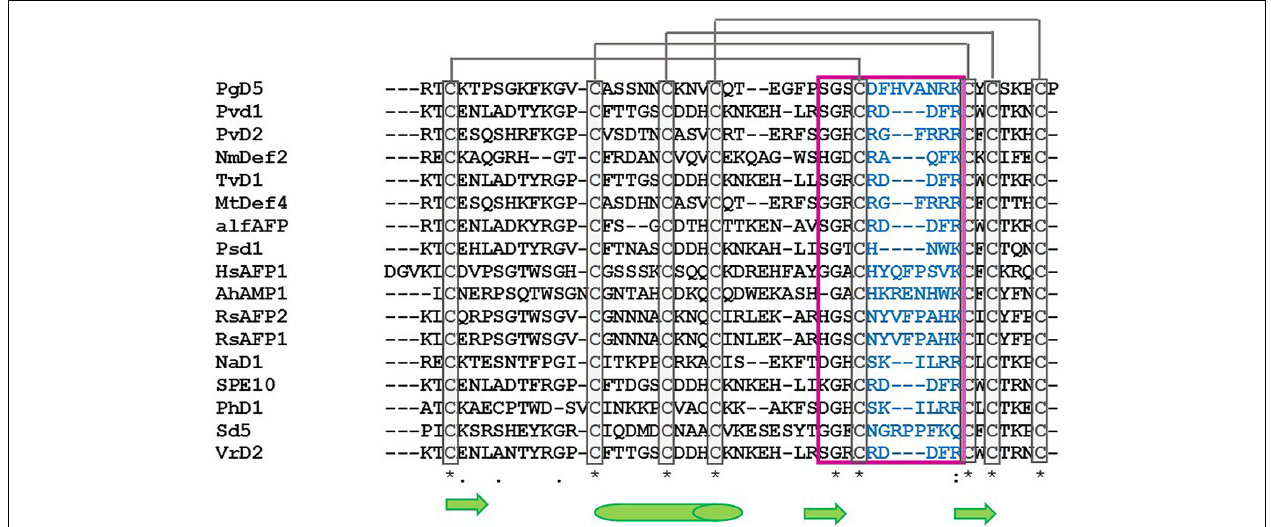
FIGURE 1 |Alignment of the amino acid sequence of antifungal plant defensins. PgD5: Picea glauca defensin (Accession: AAR84643); Pvd1: